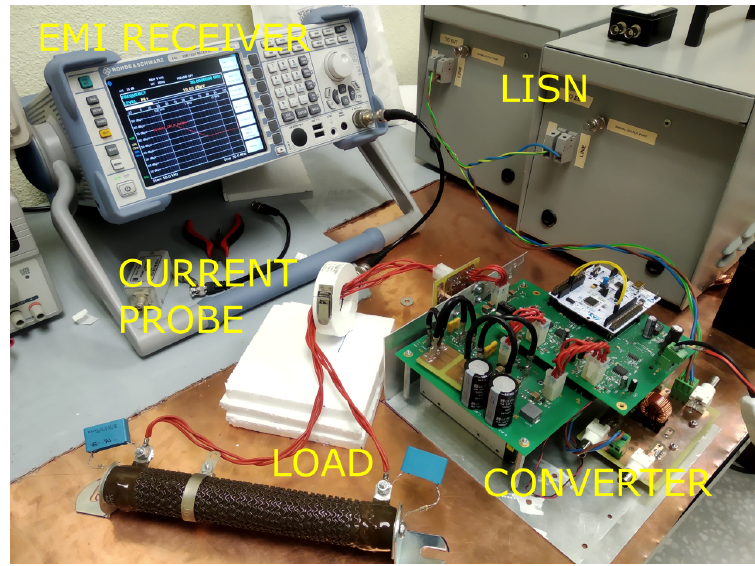
Figure 5. Experimental setup for measuring conducted emissions at the output leads of the converter.